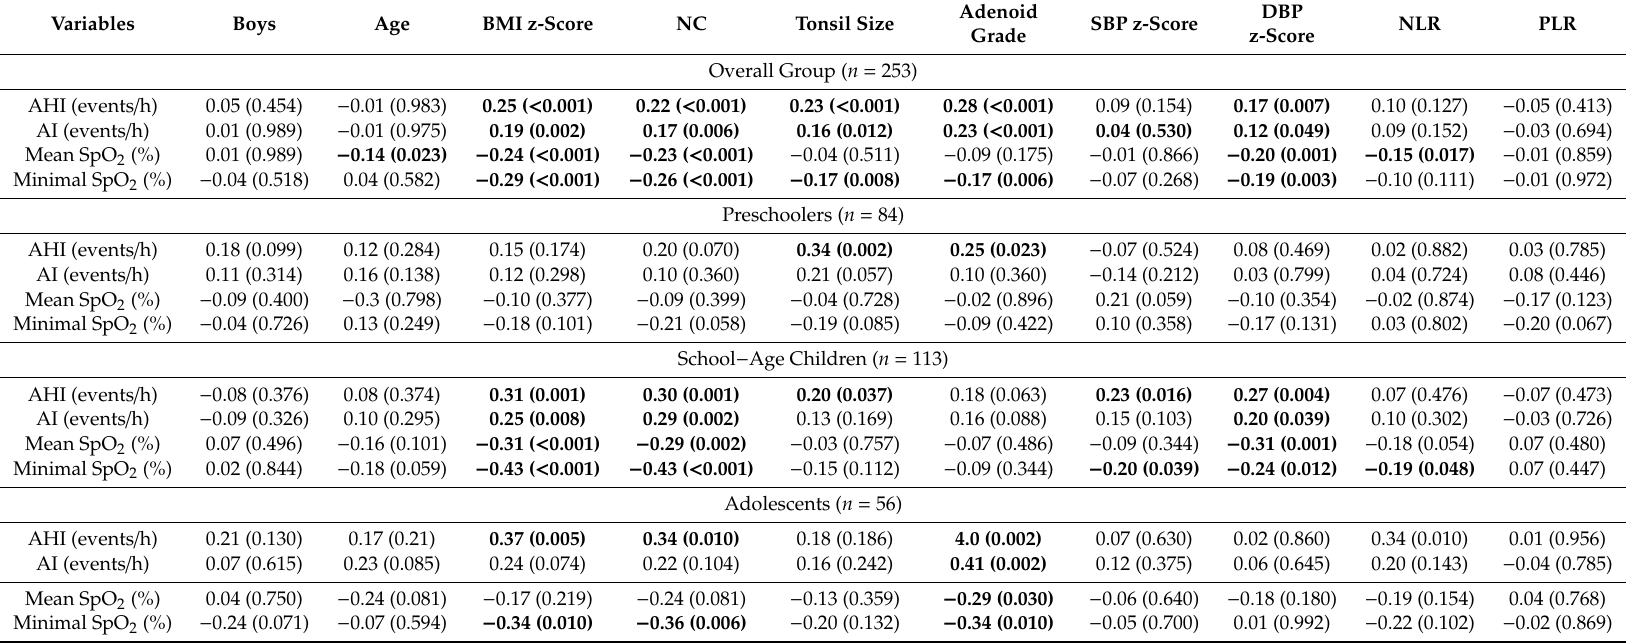
Table 2. Associations between patients’ characteristics, blood pressure, inflammatory biomarkers, and polysomnography parameters in the overall cohort and three